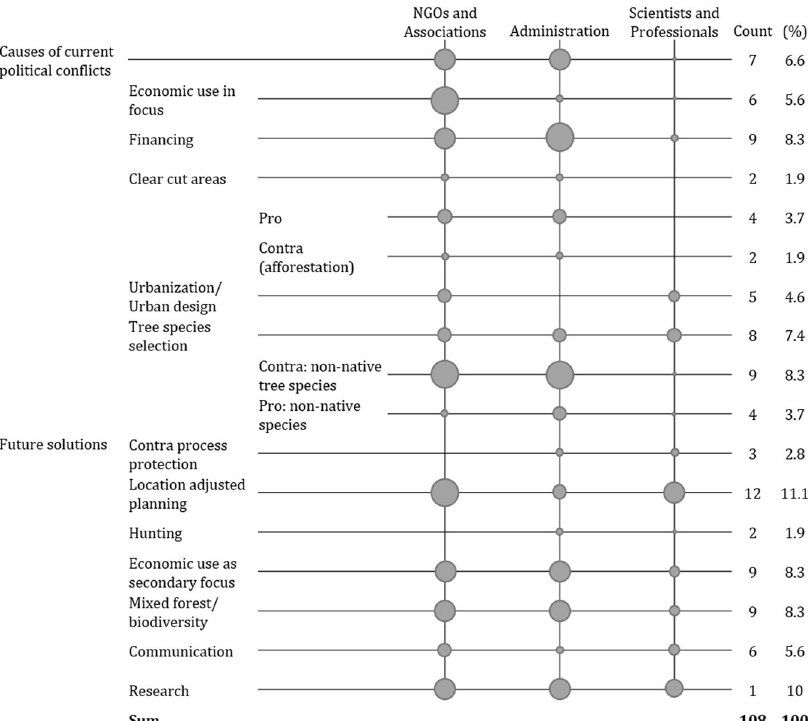
Fig. 1 Political con fl icts and future solutions for the climate change adaptation of CCF. Boxes representing the average quantity of segmented codes per interviewee per stakeholder group. Additionally, the total number of codes identi fi ed is